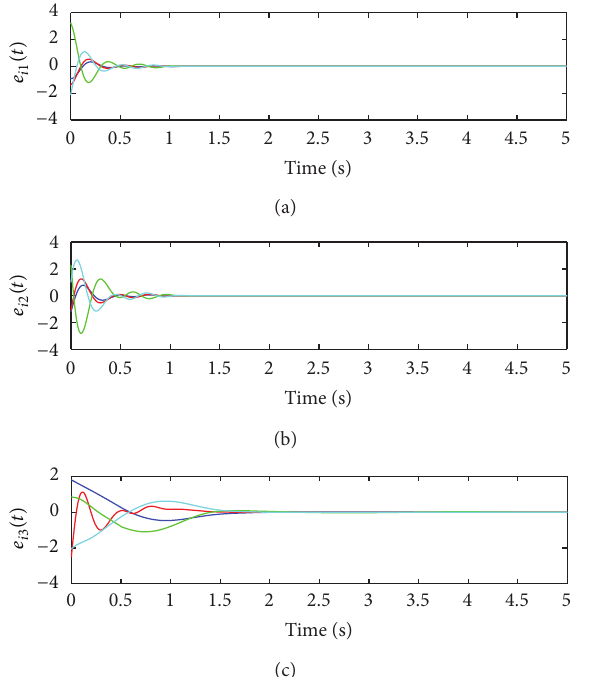
Figure 7: Synchronization errors between the states of node 𝑖 and node 𝑖 + 1 for the synchronizable subnetwork (75).